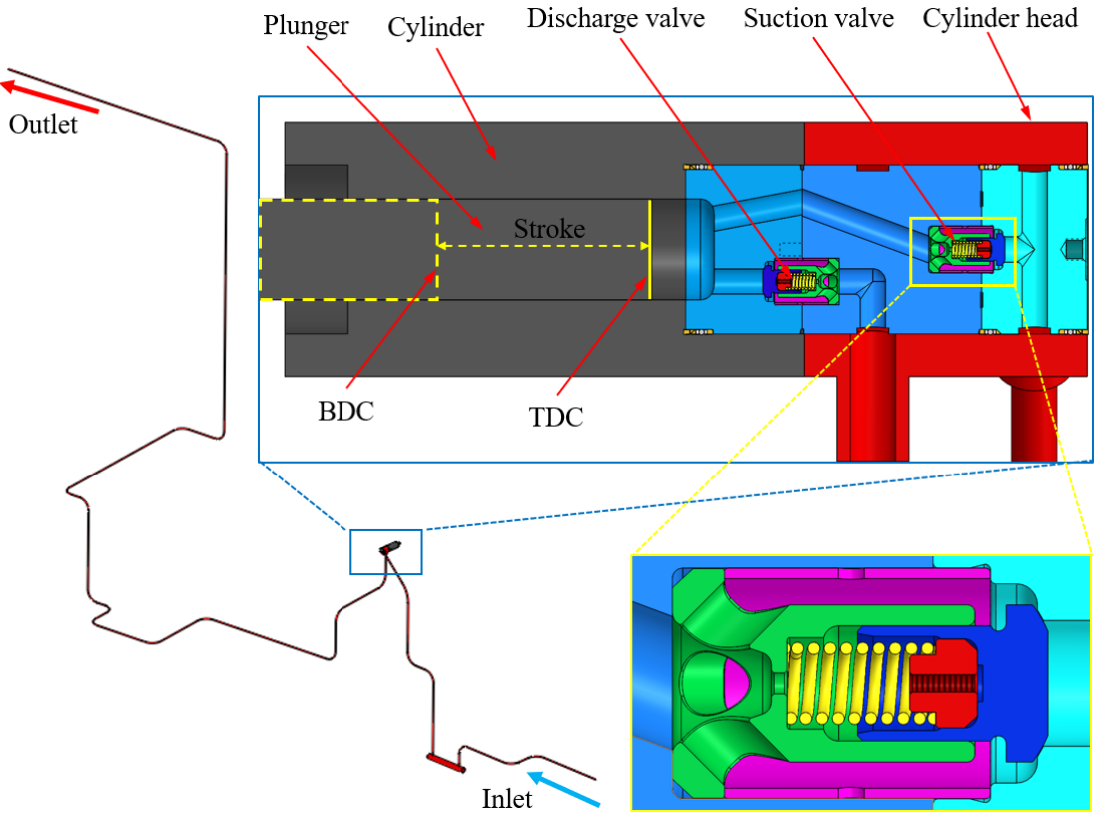
Figure 1. Solid model of the hyper compressor and its pipelines.